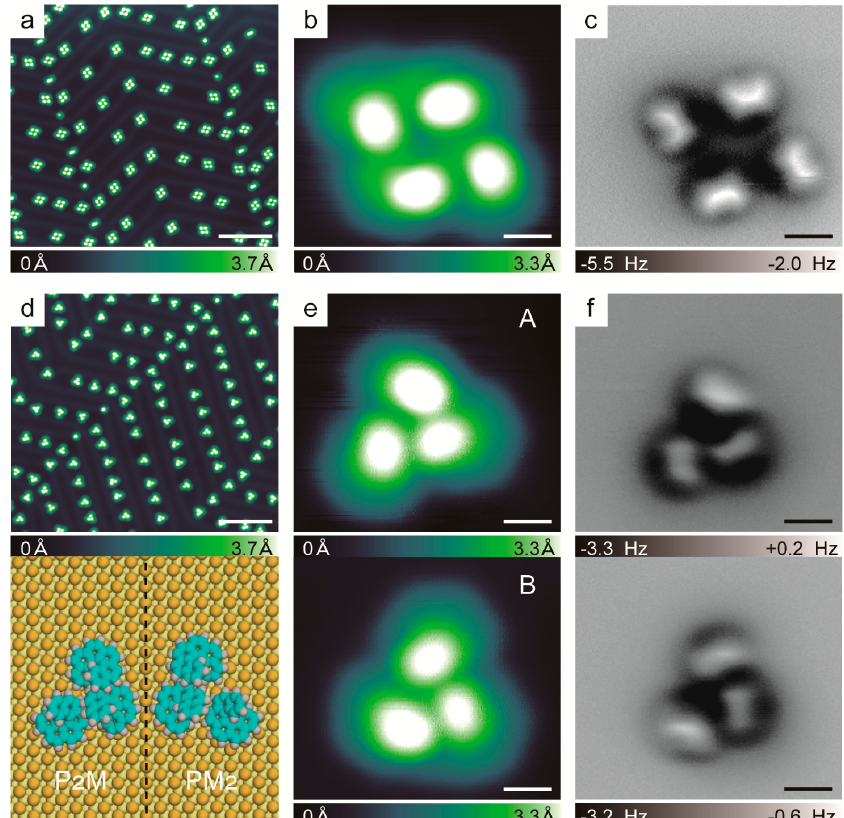
Figure 2. ( a ) Overview STM image of P -[6]H. (1000 mV, 50 pA). ( b ) Zoomed-in STM image of P -[6]H tetramer (300 mV, 10 pA). ( c ) nc-AFM images of P -[6]H tetramer measured at tip-sample distances of − 3.1 Å. ( d ) Overview STM image of rac -[6]H (1000 mV, 10 pA) and the model of two trimers with opposite handedness, (gold, yellow: top and second / third layer of Au(111), cyan: carbon, grey: hydrogen). ( e ) Zoomed-in STM images of two types of [6]H trimers A and B (300 mV, 10 pA). ( f ) nc-AFM images of the trimer A measured at tip-sample distances of − 1.6 Å and trimer B measured at tip-sample distances of − 1.65 Å. Scale bars: 5 Å ( b , c , e , f ), 10 nm ( a , d ), CO tip.